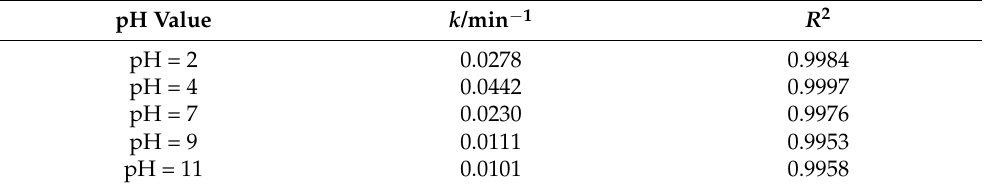
Figure 6. Degradation results of methyl orange at different pH values ( a ) and its first-order kinetic analysis ( b ). Table 3. Kinetic parameters of TiO 2 -6%RGO degradation of methyl orange solution at different pH